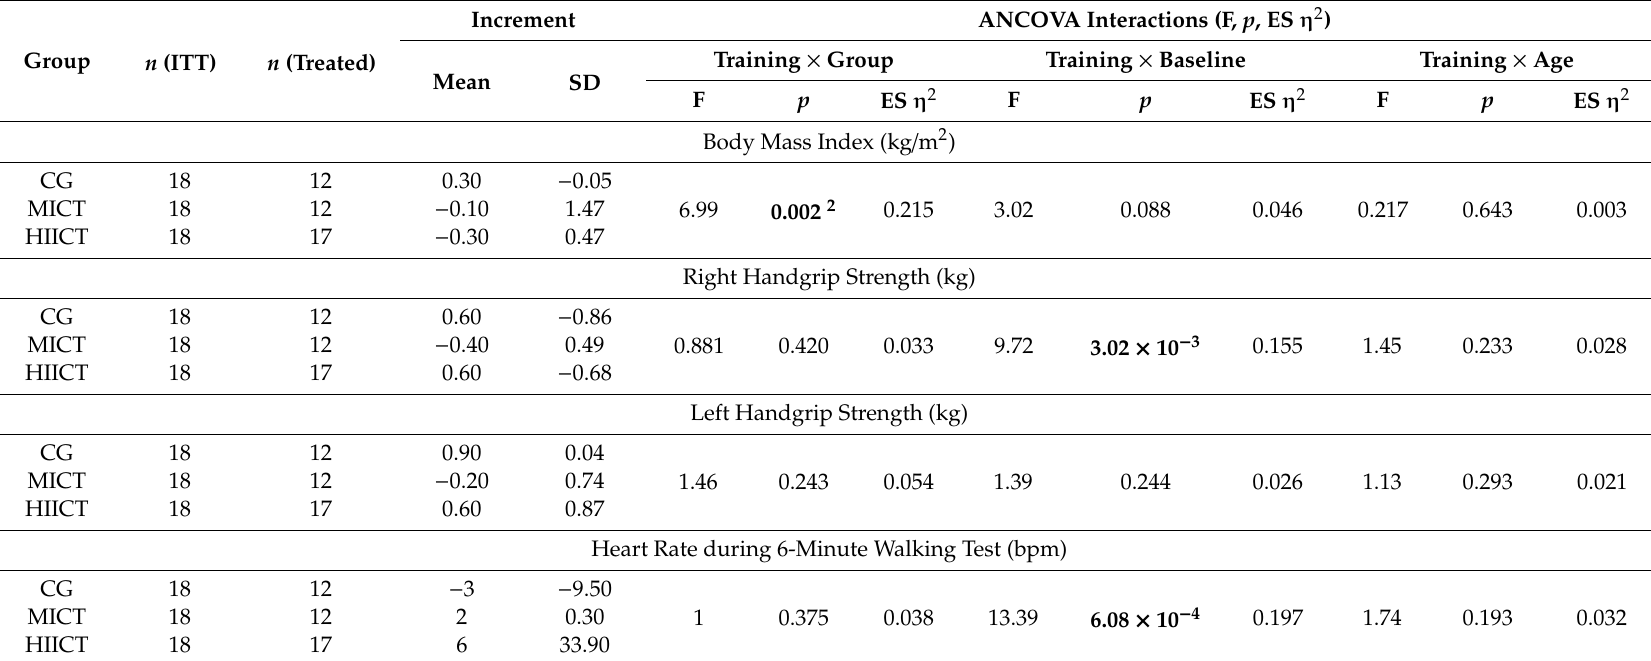
Table 5. ANCOVA adjustments for the secondary outcomes on HIICT, MICT and